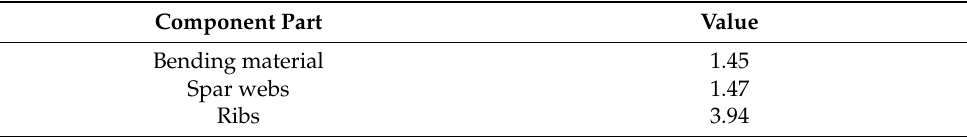
Table 2. Empirical mass factors for wing box mass.